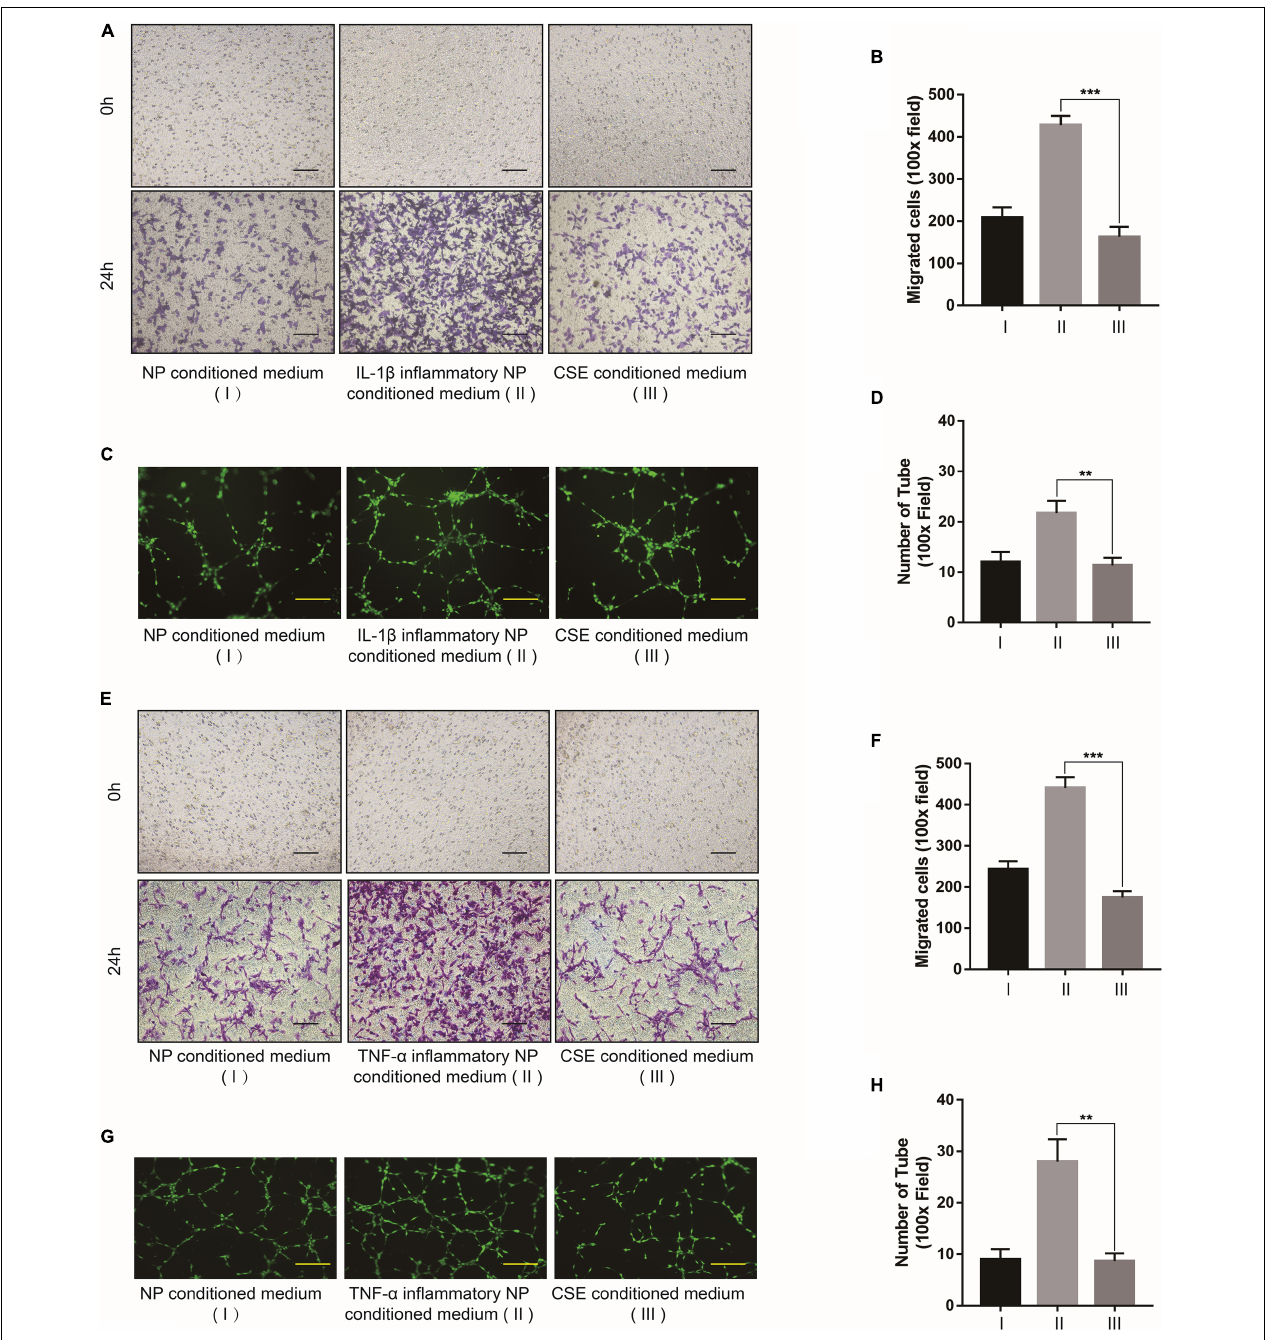
FIGURE 6 | Cystathionine- γ -lyase overexpression in NP cell inhibits vascular function. (A) Bright-field images of migrated EPCs after incubation with IL-1 β and (B) quantification by ImageJ. (C) Calcein-AM IF images of EPC tube formation assay after incubation with IL-1 β and (D) quantification by ImageJ. (E) Bright-field images of migrated EPCs after incubation with TNF- α and (F) quantification by ImageJ. (G) Calcein-AM IF images of EPC tube formation assay after incubation with TNF- α and (H) quantification by ImageJ. Black scale bar: 100 µ m. Yellow scale bar: 200 µ m.